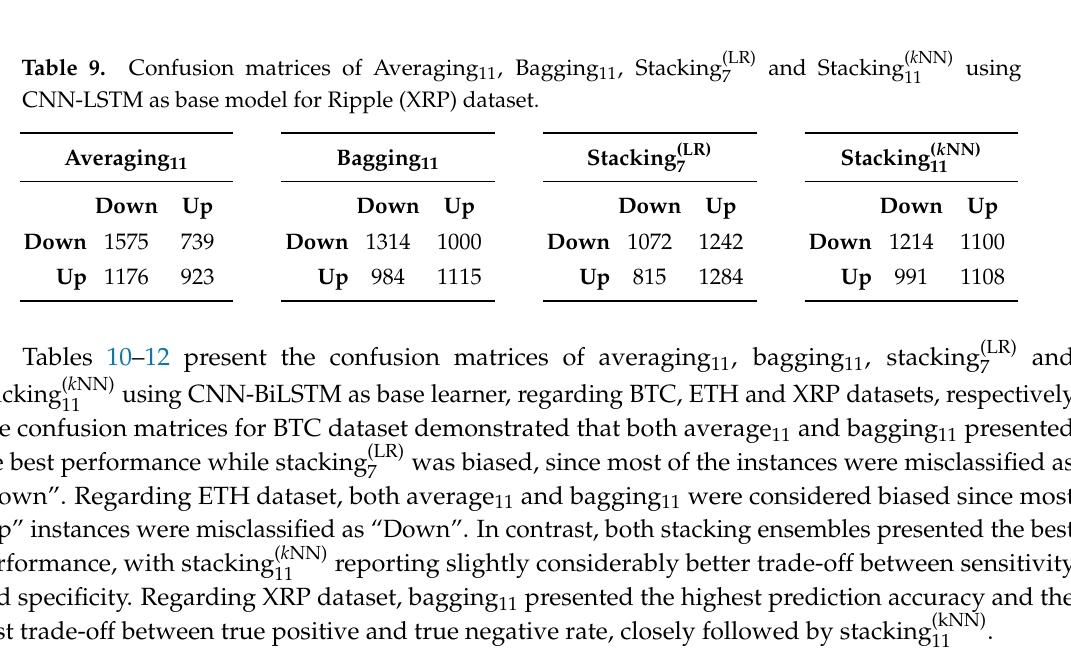
and Stacking ( k NN) using 7 11